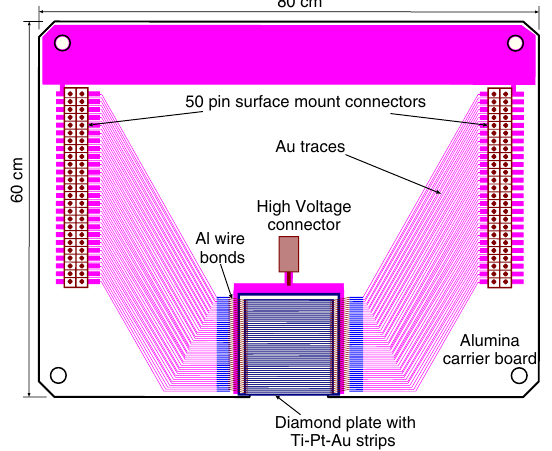
FIG. 2. A schematic diagram of the CVD diamond plate mounted on an alumina frame, which forms a single detector plane. There were 96 Ti-Pt-Au strips deposited on the front face of the diamond plate, which was attached to the frame using a silver epoxy. The strips were connected to Au traces on the alumina frame with aluminum wire bonds. The traces terminated on two 50-pin connectors. A high voltage (HV) bias of about − 300 V was applied to the back side of the diamond plate via a miniature HV